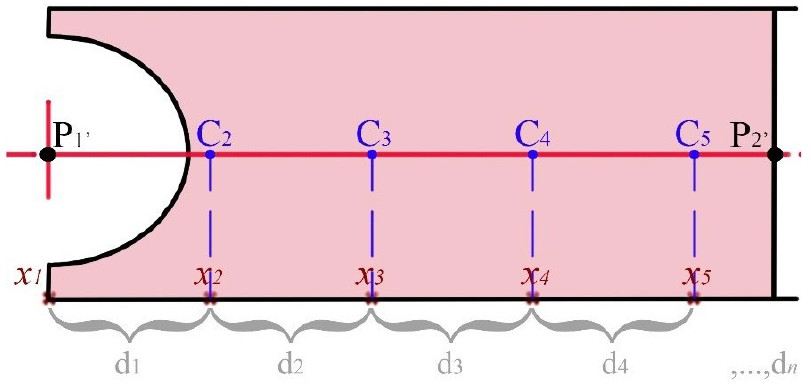
Figure 9. Division of the beam length.